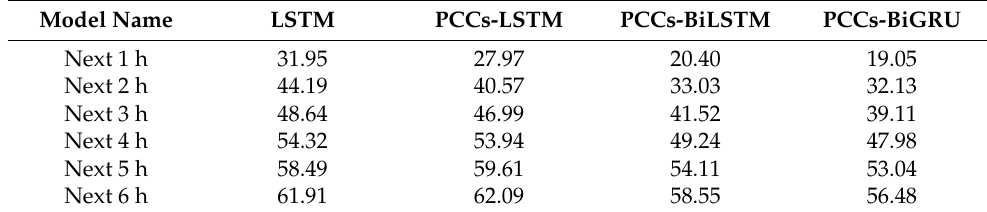
Table 6. The RMSE of PM 2.5 concentration prediction in the next six hours.